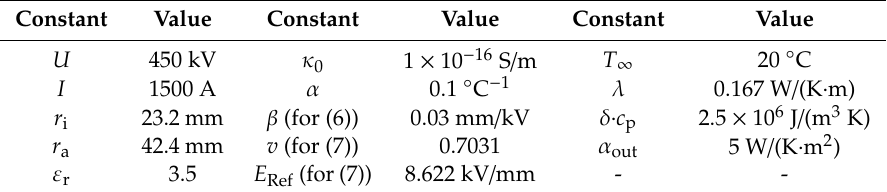
Table 1. Constants to simulate the transient electric field under load conditions in a MI cable insulation [11,30,65,66]. Constant Value Constant Value